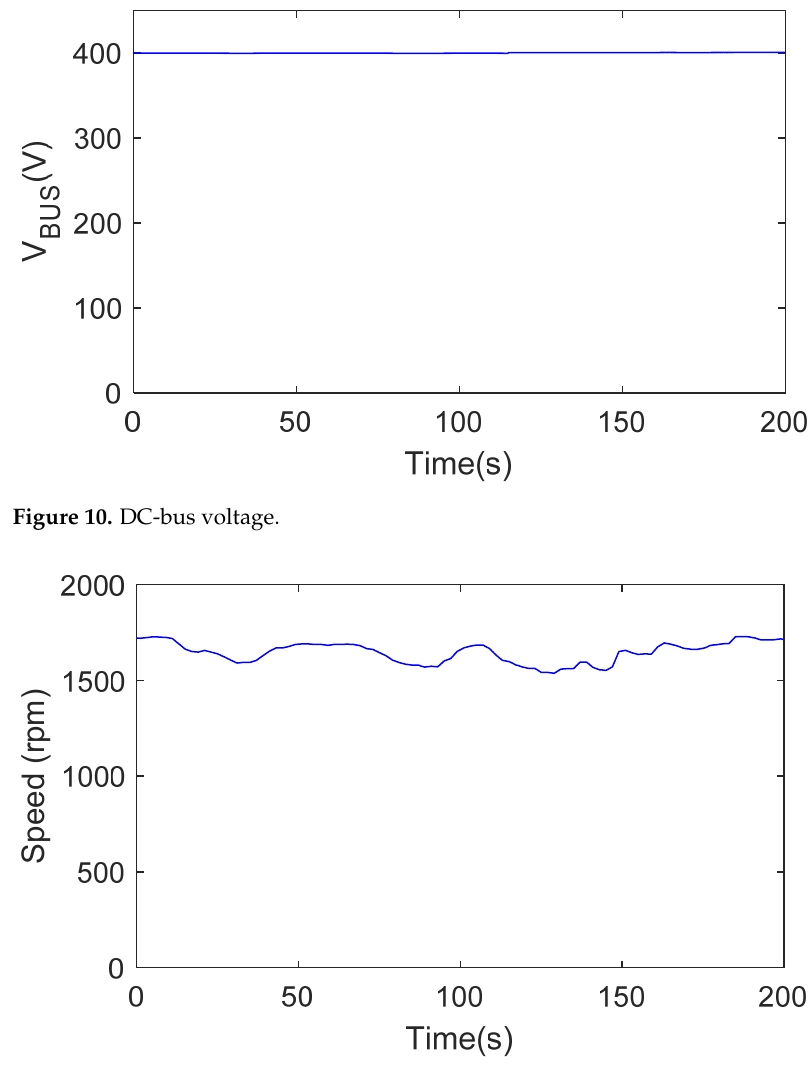
Figure 11. PMSG variable speed obtained by simulation.